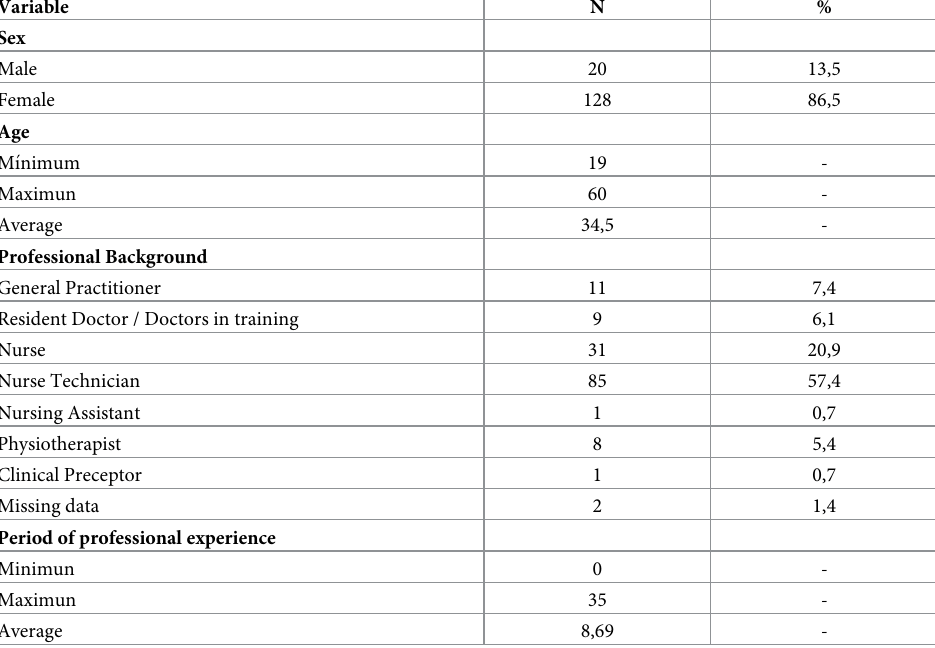
Table 1. Characterization of the sample. Ceara´, Brazil,